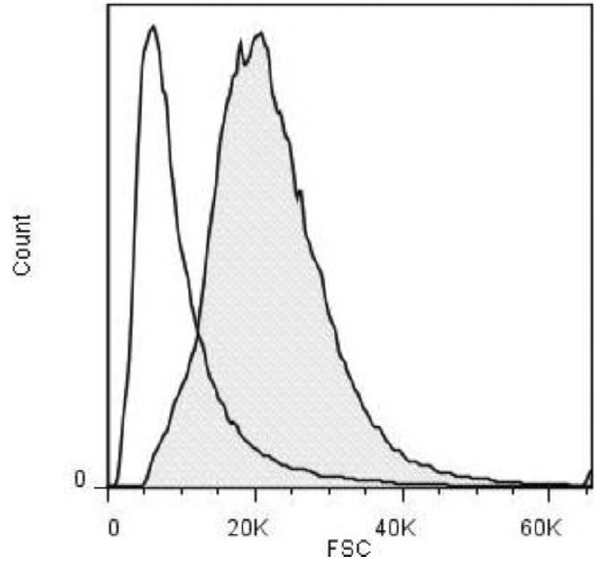
Figure 1. The surface area of strain NMB-CDC is larger than that of strain MC58. A representative flow cytometry histogram of the forward scatter (FSC) from strains MC58 (white area under the curve) and NMB-CDC (grey shaded area) analysed with the BD Influx cytometer. The mean of the FSC of NMB-CDC was 19,000 and the mean of the FSC of MC58 was 8,000 in this